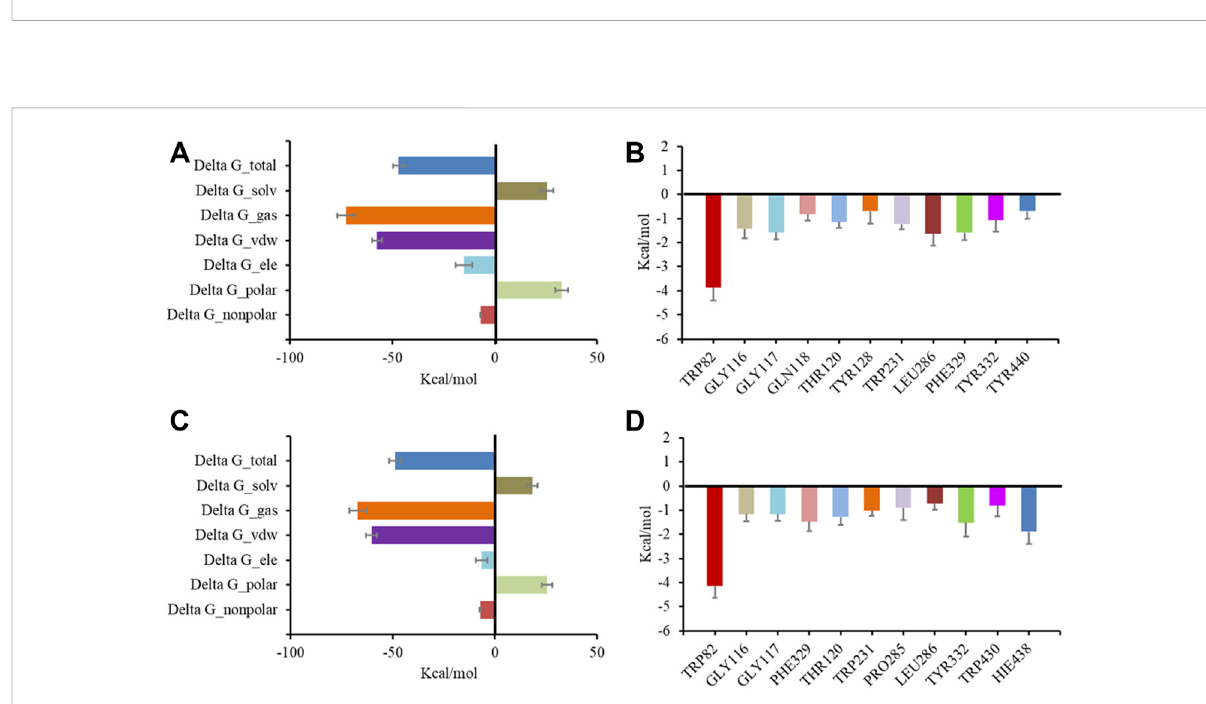
FIGURE 6 MoleculardynamicsimulationresultsforBChEwithinhibitors.Totalbindingfreeenergyanditscomponentfor 6(A) and 7(C) with5k5e;residue contribution to receptor-ligand complexes for 5k5e with 6 (B) and 7 (D)